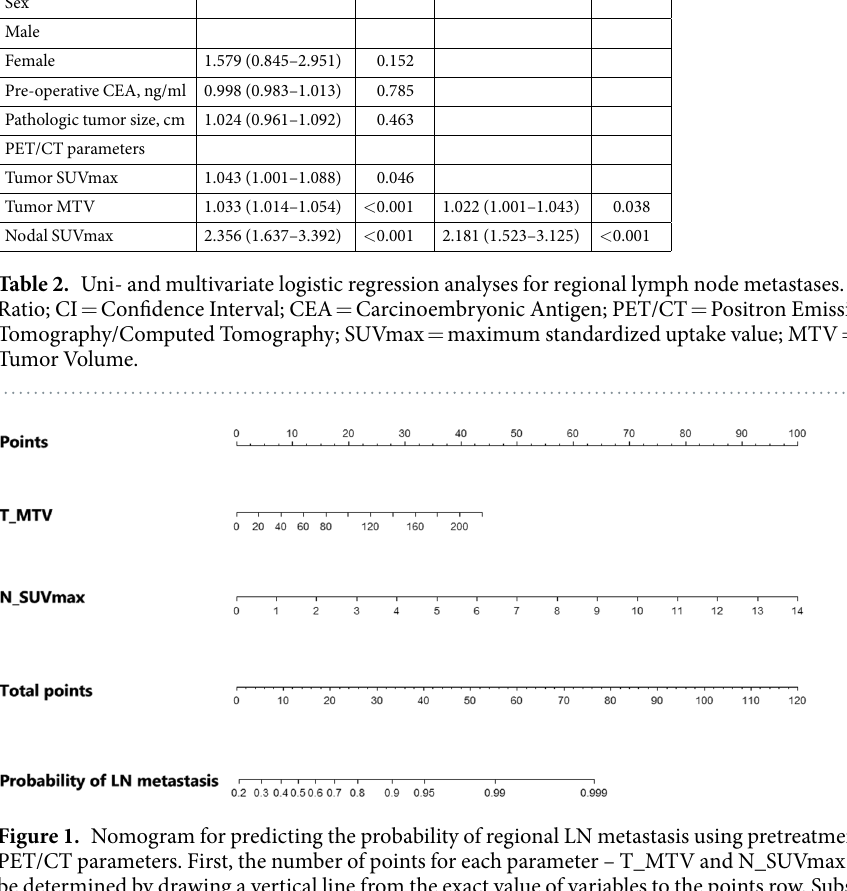
Comparison of LN Metastasis prediction performance. When LN metastases prediction performance